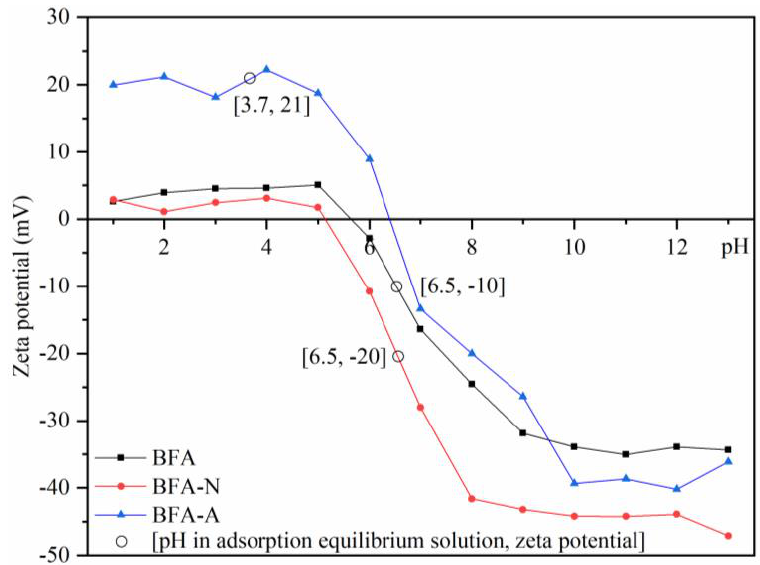
Figure 4. Zeta potentials of BFA, BFA-N, and BFA-A as a function of solution pH.